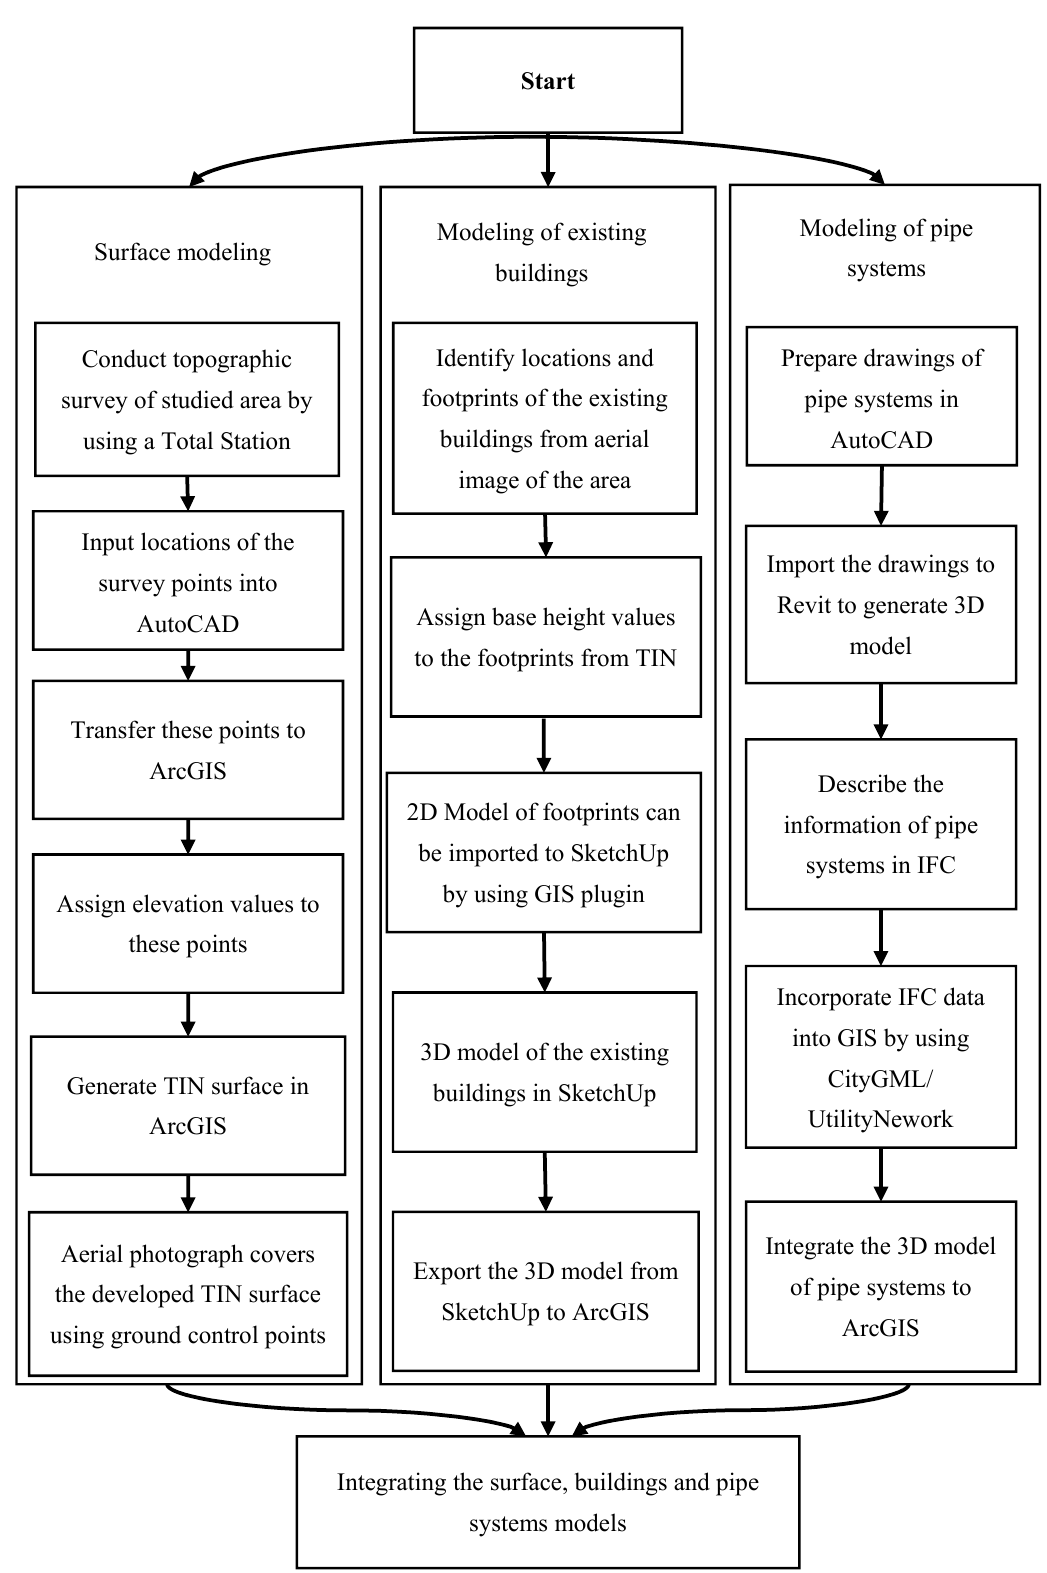
Figure 6. The development process for the 3D model of the water distribution system (WDS) and its surroundings.